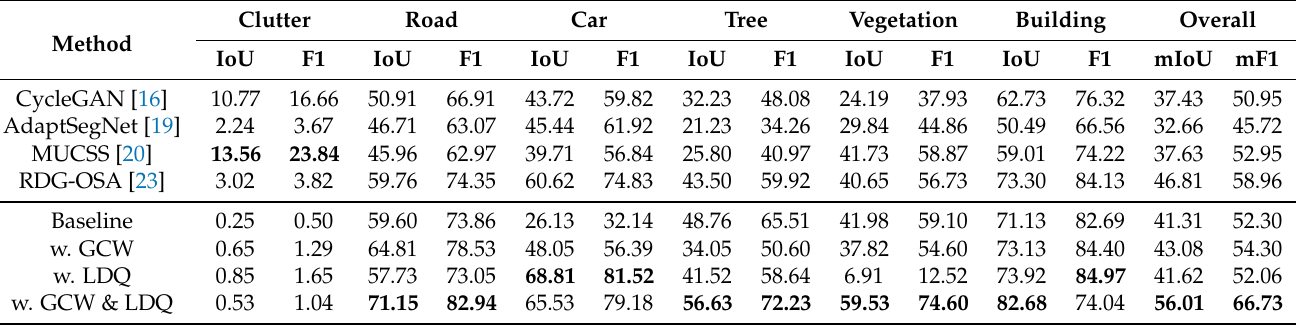
Table 2. Quantitative results (%) on VAI →